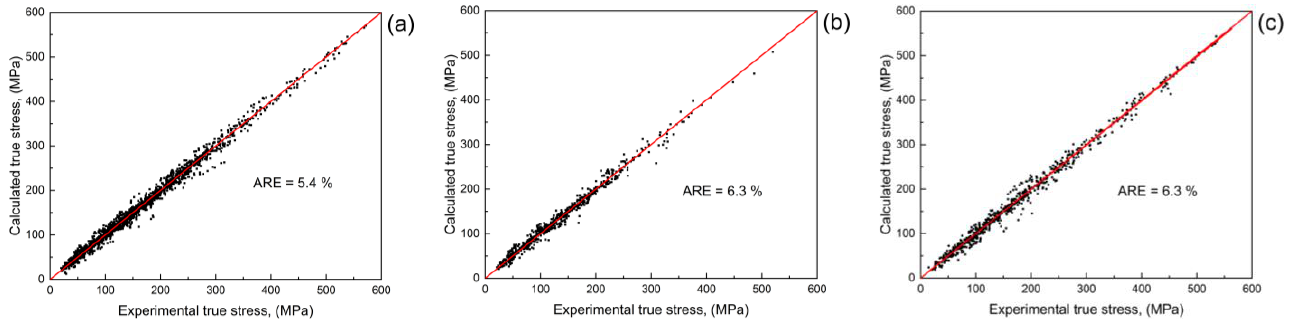
Figure 2. A matching between calculated using a built ANN-based model and real true stresses for ( a ) training dataset, ( b ) cross-validation dataset, and ( c ) testing dataset.